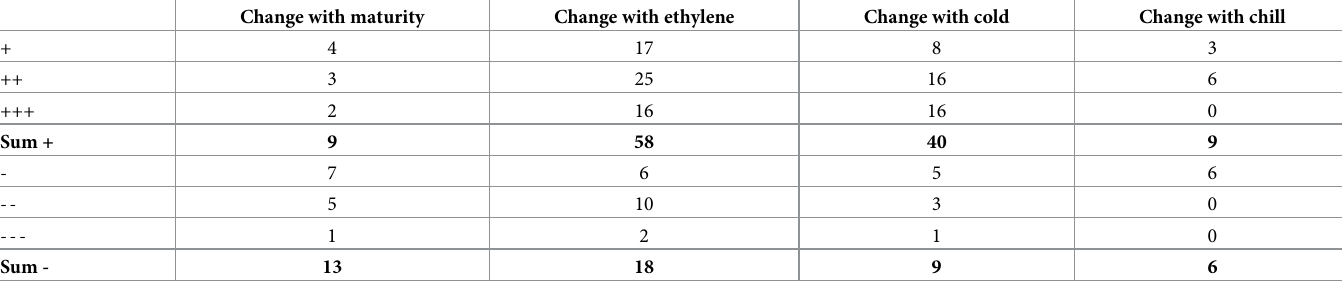
Table 2. Summary of expression of AP2/ERF